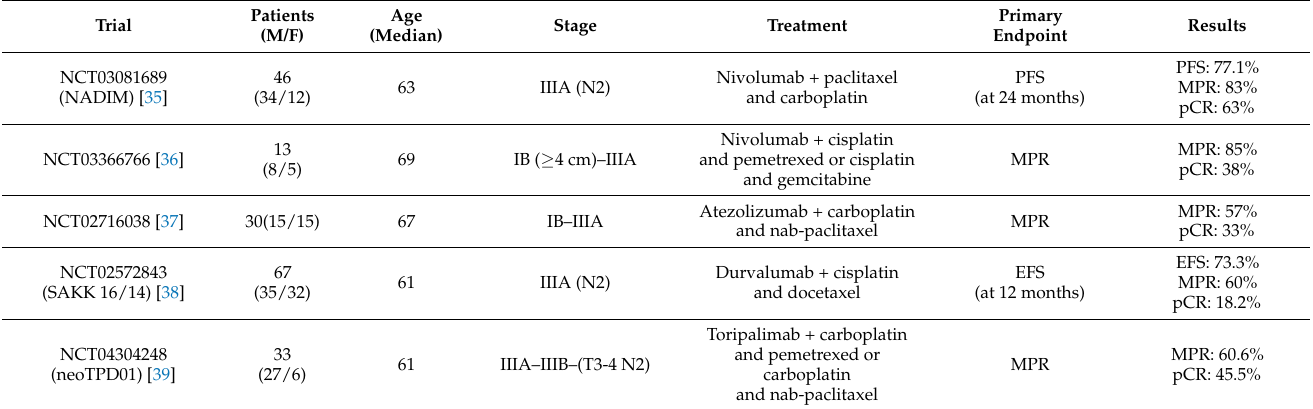
Table 1. Results of neoadjuvant phase II clinical trials with chemotherapy and immunotherapy. M: Male; F: Female; PFS: progression-free survival; EFS: event-free survival; MPR: major pathological response; pCR: pathological complete